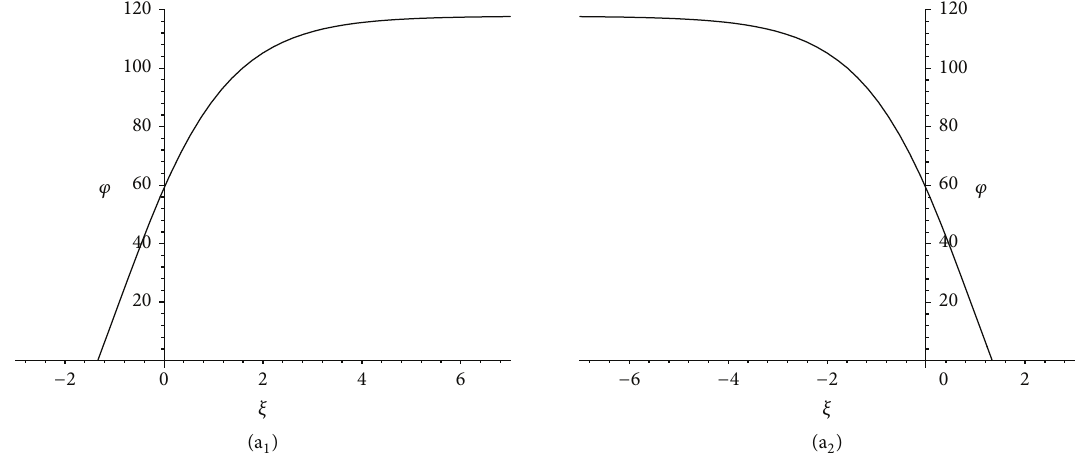
Figure 4: (Corresponding to Example 2). The simulation of integral curve of (6) when 𝑎 = 1/2 , 𝑏 = −2/45 , 𝑐 = 1 , and 𝛿 = 1 . (a 1 ) Initial conditions 𝜑(0) = 58.90576474 and 𝜑 󸀠 (0) = 38.27939786 . (a 2 ) Initial conditions 𝜑(0) = 58.90576474 and 𝜑 󸀠 (0) = −38.27939786